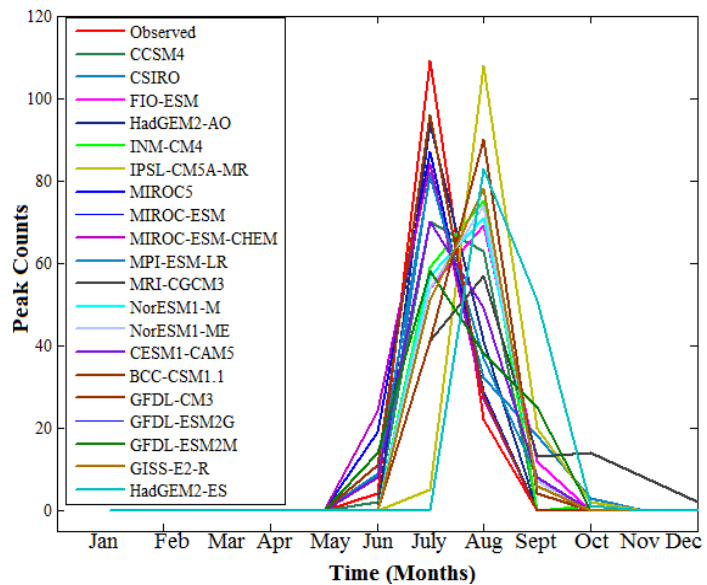
Figure 2. MRPM count for all-India observed and models for all months over the time period 1871–2005.